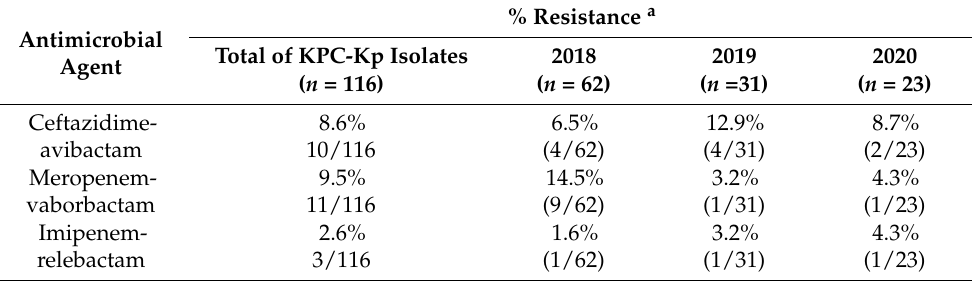
Table 1. Three-year trend of resistance to β L- β LICs in KPC-Kp strains isolated from BSIs. Antimicrobial